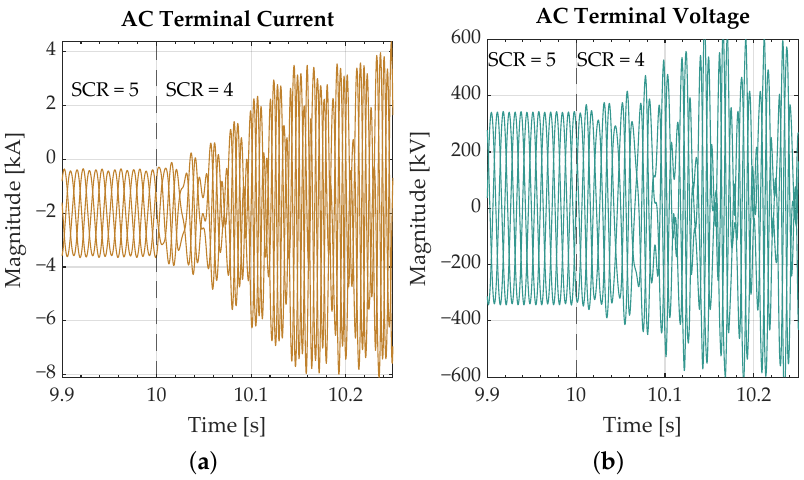
Figure 11. AC terminal current ( a ) and voltage ( b ) when switched to an AC grid with SCR = 4.